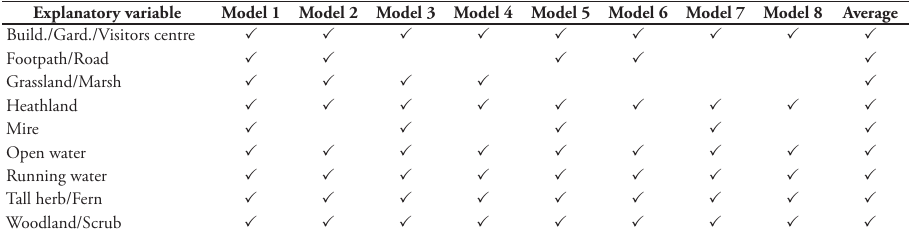
table 3. Explanatory variables which were included in each of the top 8 models produced. All explana- tory variables were included in the final average